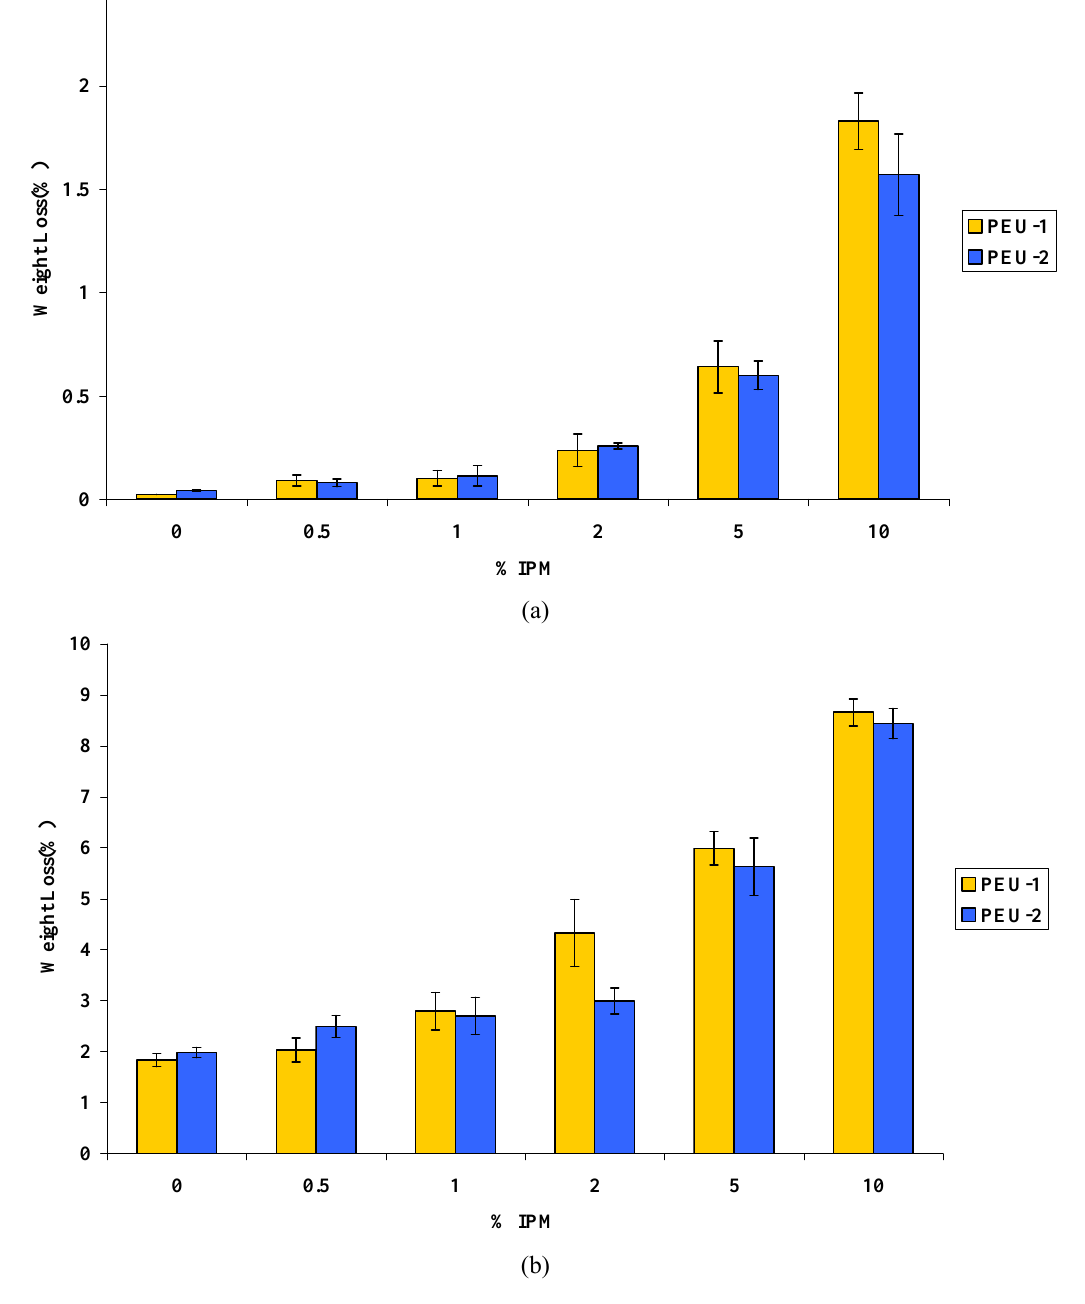
Figure 3. IPM leaching from polyurethane after 10 days immersion in (a) PBS; (b) BSA at 37 °C.